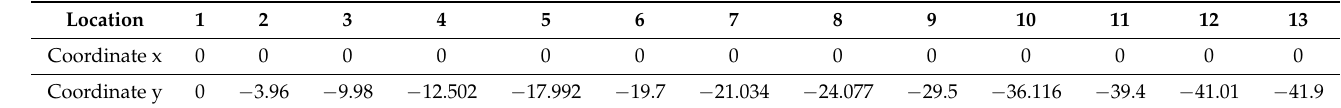
Figure 2. Top view showing detector regions (A, B, C, D, E, and F) and interaction locations indicated with the “x” symbol in orange color. Table 1. The measured coordinates of the interaction locations shown in Figure